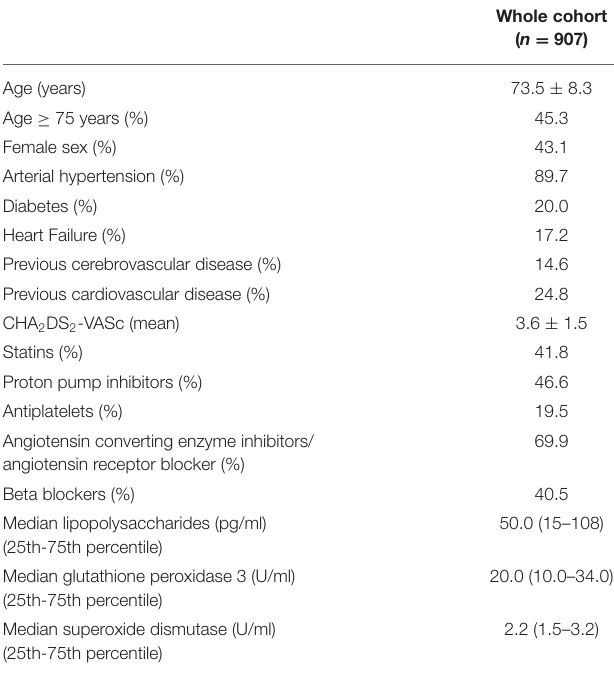
TABLE 1 | Clinical characteristics of the ATHERO-AF